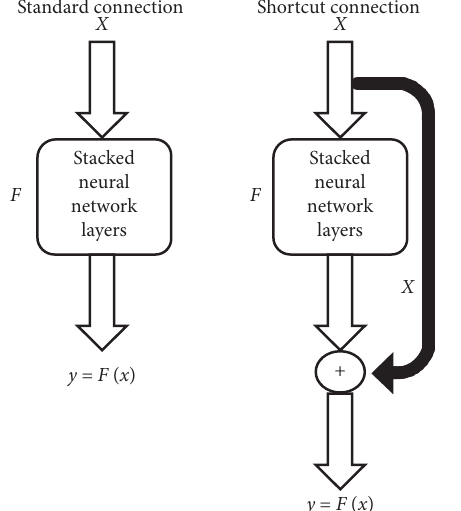
Figure 2: Difference between a standard connection and a shortcut/skip